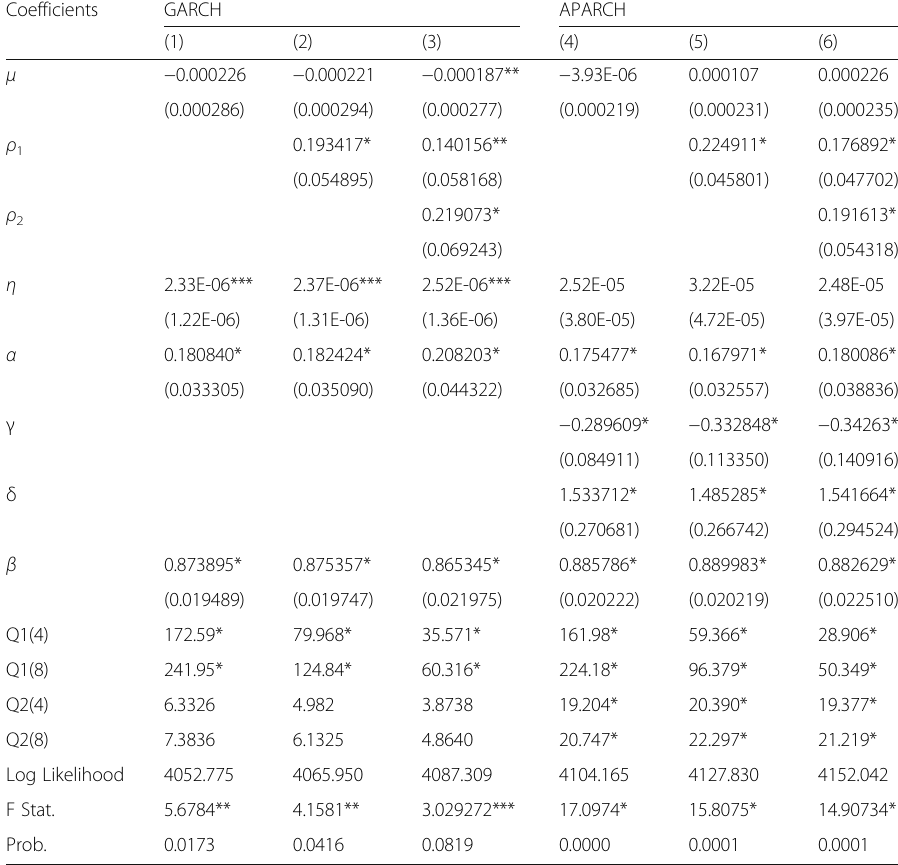
Table 2 Estimation results of GARCH and APARCH models with normal distribution